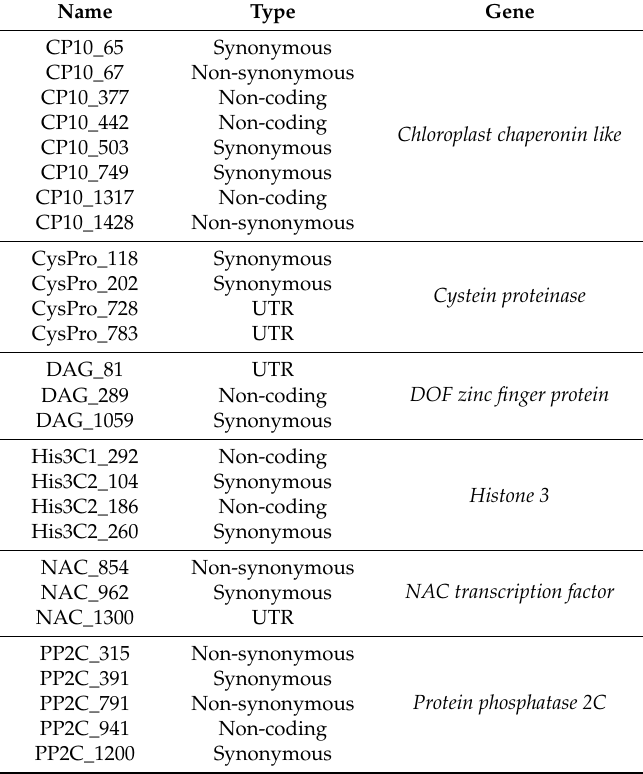
Table 2. SNPs used for